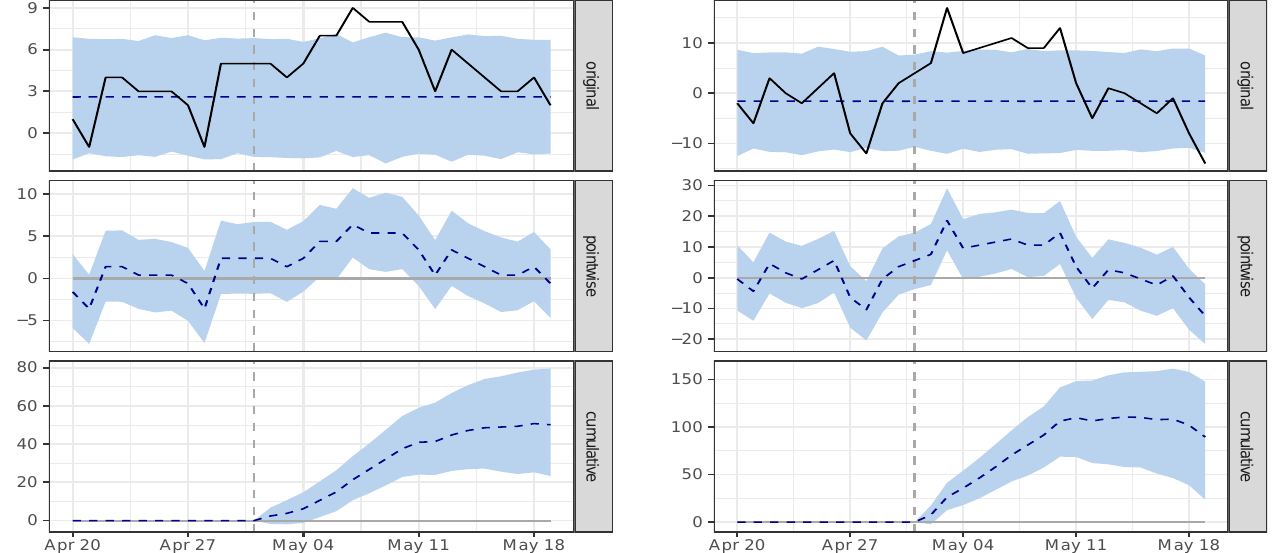
Figure 13. Left : Effect of the national full lockdown Level 5 on workplaces Right : Effect of the national full lockdown Level 5 on transit